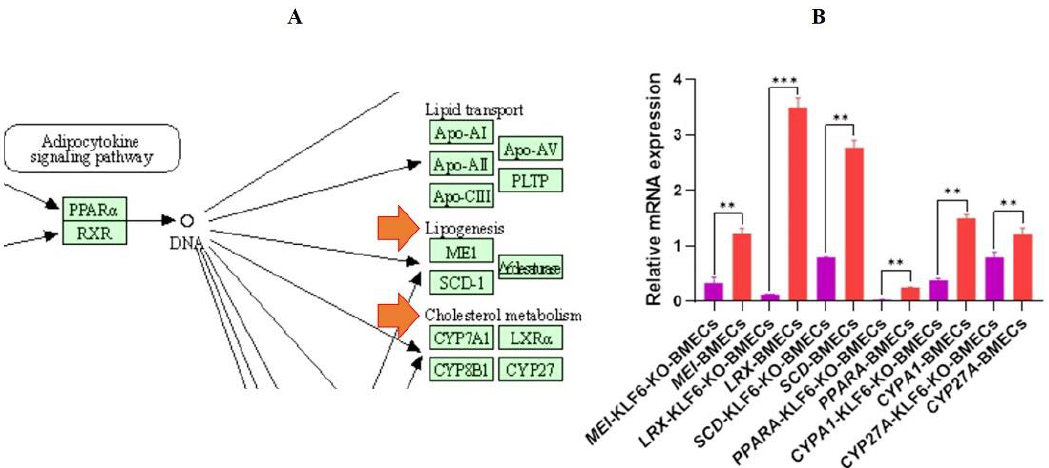
Figure 14. Analysis of lipid metabolism-related genes ( A ) The KEGG pathway of PPARA. Arrows points out the PPARA pathways genes associated with lipogenesis and cholesterol metabolism ( B ) The relative mRNA expression of PPARA and its pathway related genes in the KLF6 -KO-BMECs and normal BMECs. ** p < 0.01, *** p <